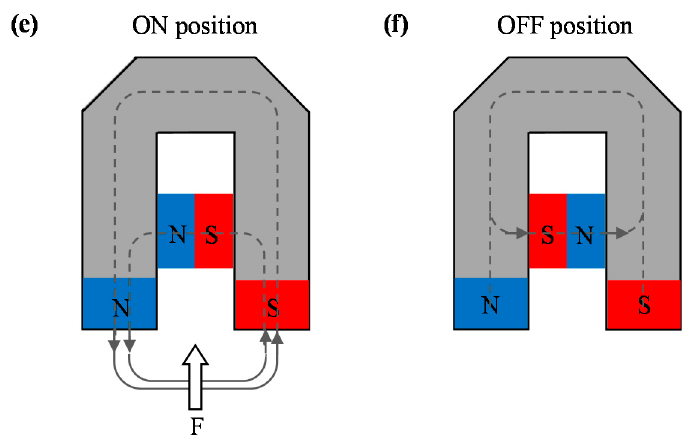
Figure 1. ( a ) General view of lifting magnet; ( b ) bottom surface of the lifting magnet; ( c ) the handle on the lifting magnet at ON position; ( d ) the handle on the lifting magnet at OFF position; ( e ) schematic of magnetic field at ON position; and ( f ) schematic of magnetic field at OFF position.